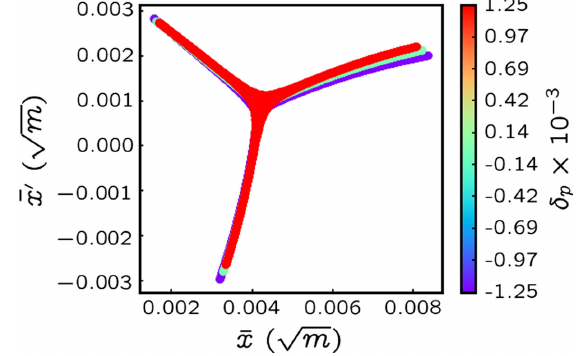
FIG. 1. Change of separatrix presentation at the ES during the spill for SPS quadrupole driven slow extraction with main quadrupoles (tune sweep). The different colors indicate the separatrices for different momenta.